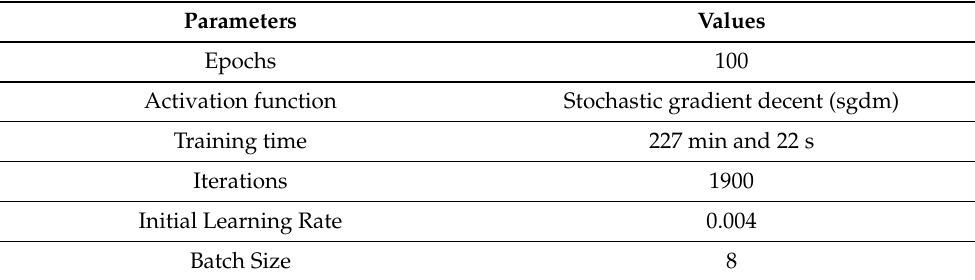
Table 4. Parameters setting considered during the training and testing of proposed CNN.